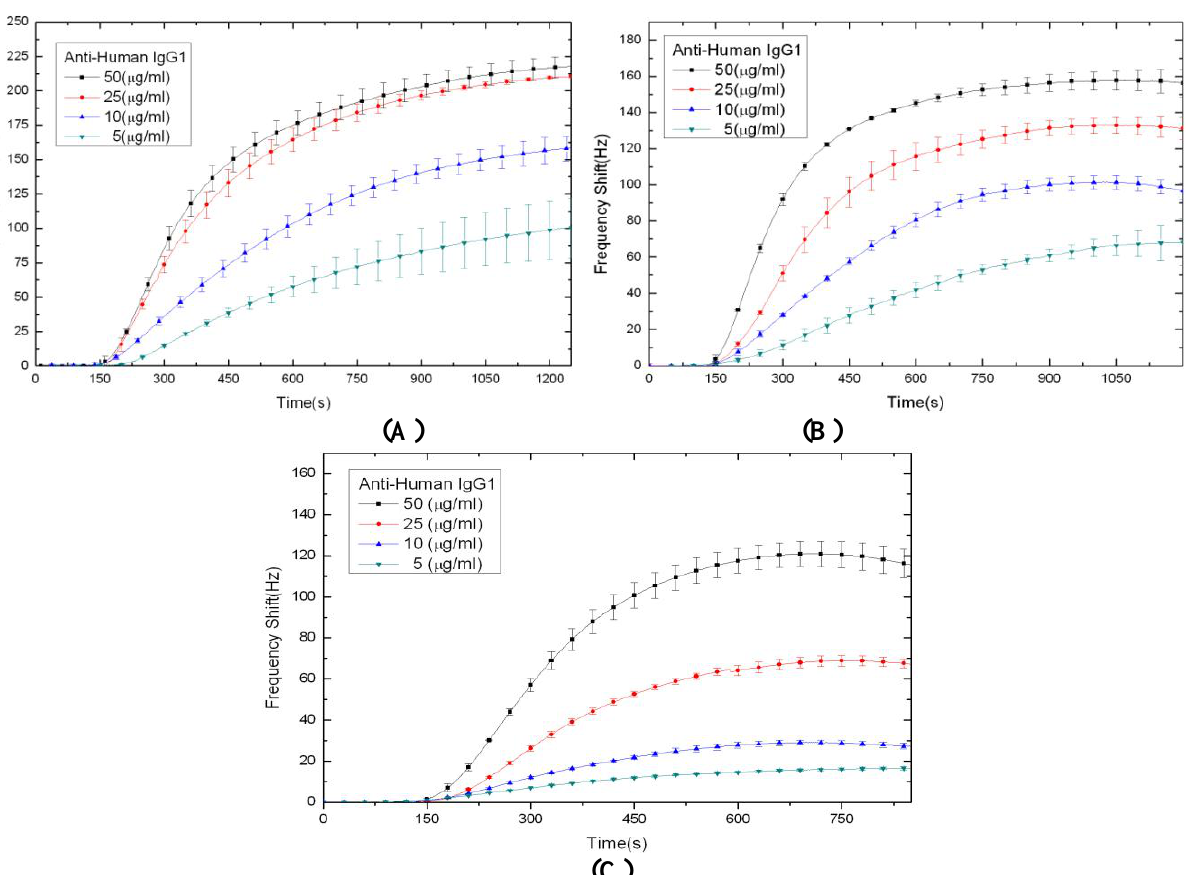
Figure 3. The (Human IgG1)-(Anti-Human IgG1) protein pair binding curves. The supplemented volume of the Anti-Human IgG1 solution is: (A) 800 μL, (B) 500 μL and (C) 100 μL. For each case there are four concentrations of Anti-Human IgG1 solution (50, 25, 10 and 5 μg/mL). The error bar at each time point is marked according to 4~5 replicates of the experimental raw data; namely picking the largest positive (negative) deviation value as our upper (lower) bound to the average